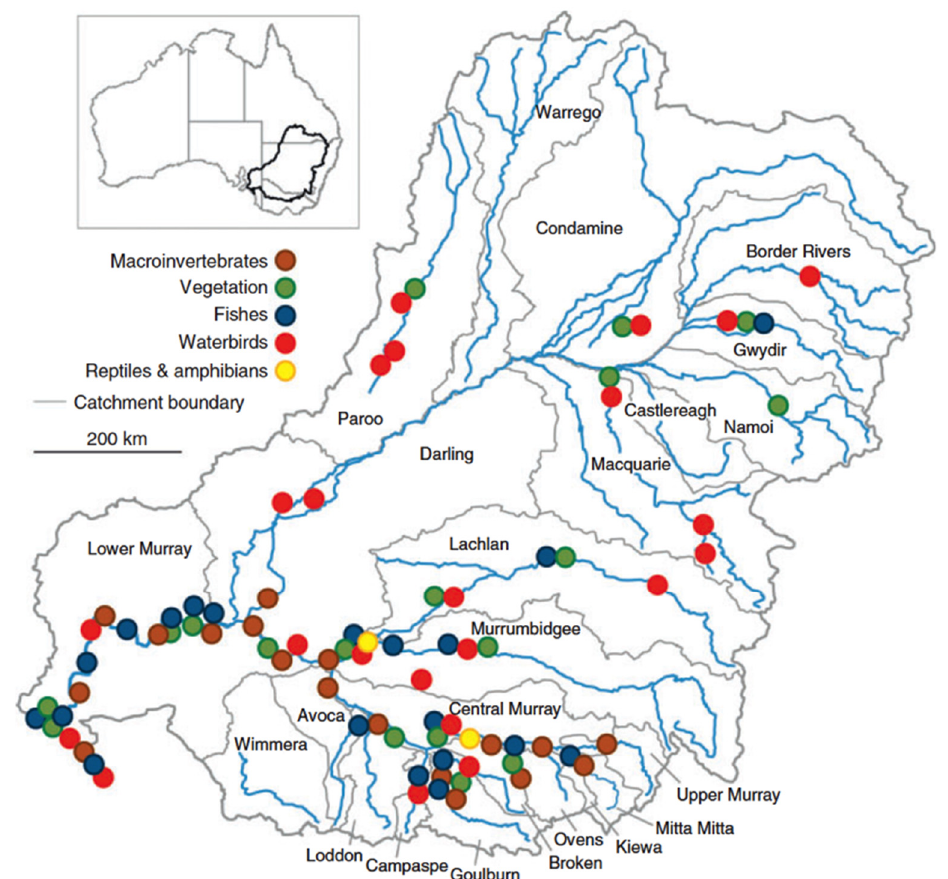
Figure 2. Locations within the Murray–Darling Basin where long-term data series were collected. Source: [9].